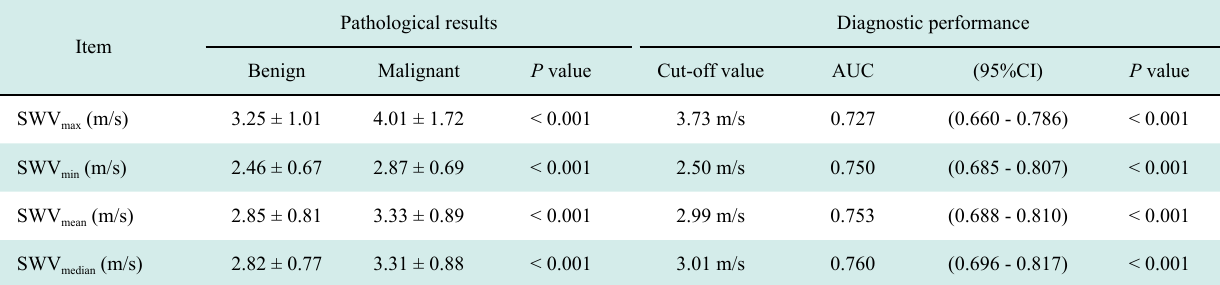
Table 2 Comparison of various elasticity indices values of VTIQ and their AUC between benign and malignant thyroid nodules Pathological Item